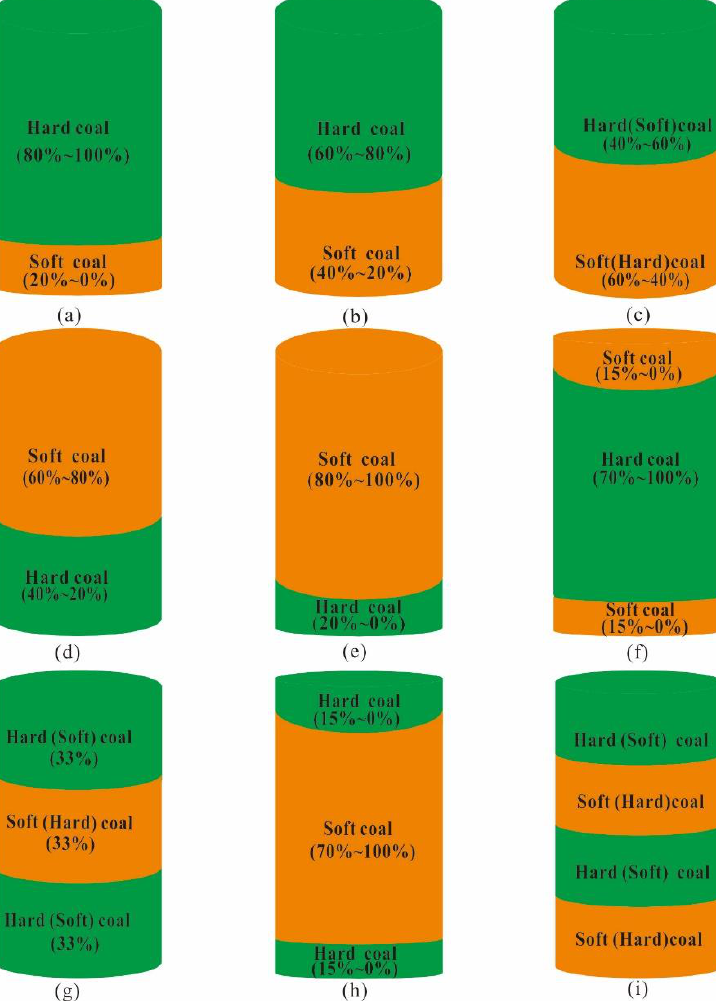
Figure 7. Classification of coal reservoirs with different coal structure combination. ( a ) Up-down type I reservoir; ( b ) Up-down type II reservoir; ( c ) Up-down type III reservoir; ( d ) Up-down type IV reservoir; ( e ) Up-down type V reservoir; ( f ) Intervening interval type I reservoir; ( g ) Intervening interval type II reservoir; ( h ) Intervening interval type III reservoir ; ( i ) Multi-layer superposition type reservoir.